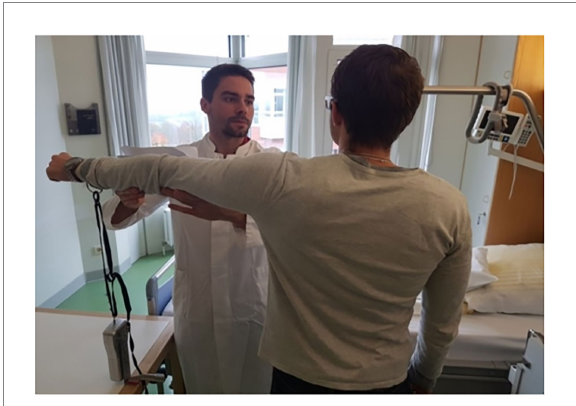
FIGURE 1 Test setup. For dynamometry of maximal arm muscle strength during abduction the patient stands upright, facing the tester, with the dominant arm stretched to the side and the wrist connected to the dynamometer by a band. Photo taken by NZ: MS with a patient, showing the standardized positioning.